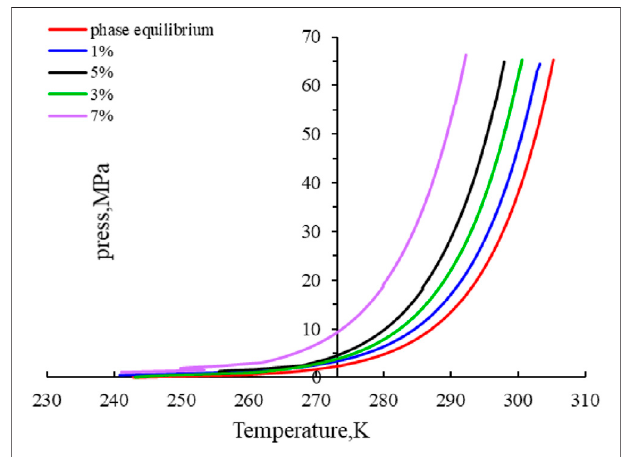
FIGURE 15 | Phase equilibrium curve of gas hydrate